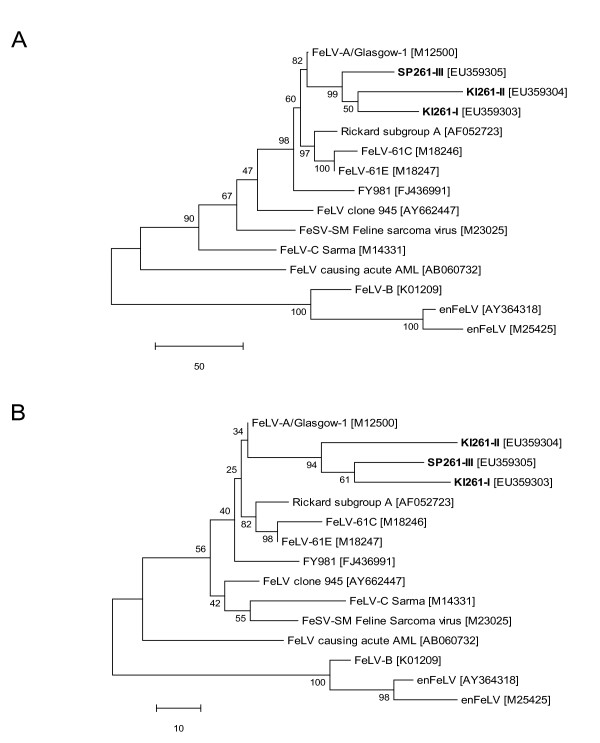
Evolutionary relationship of the three SU variants found in cat #261. Phylogenetic trees were constructed by the MP method. Trees were drawn to scale, with the length being relative to the number of changes over the entire sequence. The percentage of replicate trees in which the associated taxa clustered together in the bootstrap test (1,000 replicates) is shown next to the branches. A) Relationships at the DNA level. MP tree length: 765. The codon positions included were 1st + 2nd + 3rd + noncoding. There were a total of 1,363 base positions in the final dataset of which 349 were parsimony-informative. B) Relationships at the protein level. MP tree length: 329. There were a total of 453 amino acid positions in the final dataset of which 121 were parsimony-informative. GenBank accession numbers of the sequences included in the phylogenetic analyses are noted in square brackets following the virus identity. SP261-III, KI261-I and KI261-II (depicted in bold) were derived from cat #261.